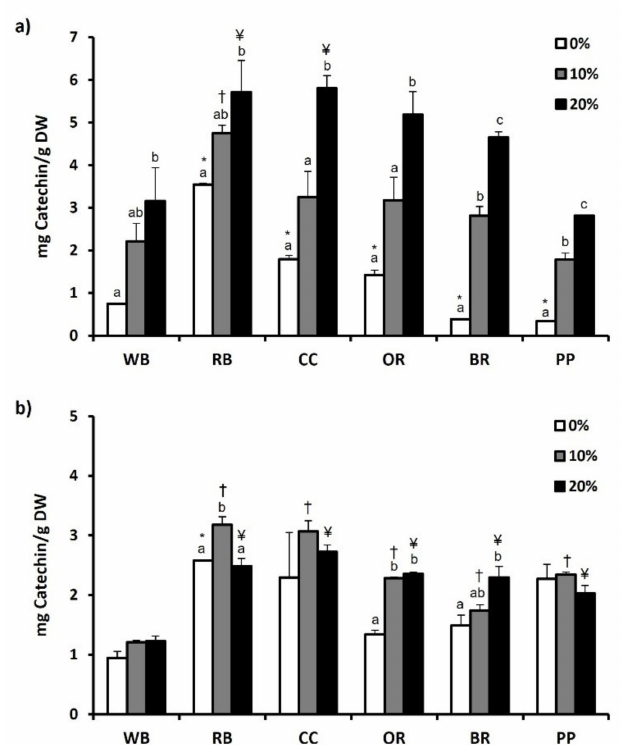
Figure 2. Total flavonoid content of ( a ) agri-food substrates and ( b ) Tenebrio molitor larvae reared on the respective substrates (WB, Wheat bran; RB, Rice bran; CC, Corn cob; OR, Olive oil residues; BR, Biogas residues; PP, Potato peel). Different bar colors depict supplementation percentage of post-distillation residues of medicinal and aromatic plants (MAPs) in the substrates. Bars repre- sent mean values of three replicates ± SE. Different letters depict significant differences regarding MAPs post-distillation residues supplementation in each substrate, while different symbols are used (*, †, ¥) to denote significant differences between substrates compared to the WB in the respective supplementation percentage of MAPs post-distillation residues (0%, 10%, 20%,